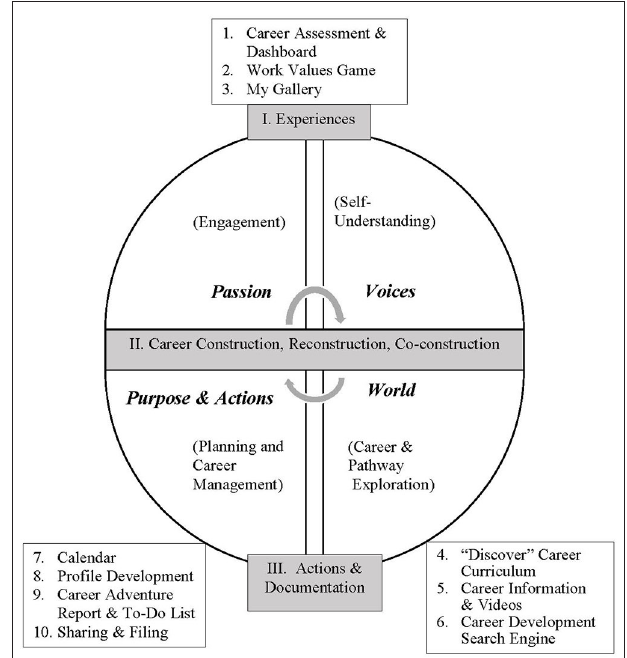
FIGURE 1 | The learning and organizational framework of the infinity system a : career planning steps and career construction b . a Infinity applications are numbered from 1 to 10. Please refer to Table 1 for description of the functions of the applications. b The CCT learning process is indicated in the shaded